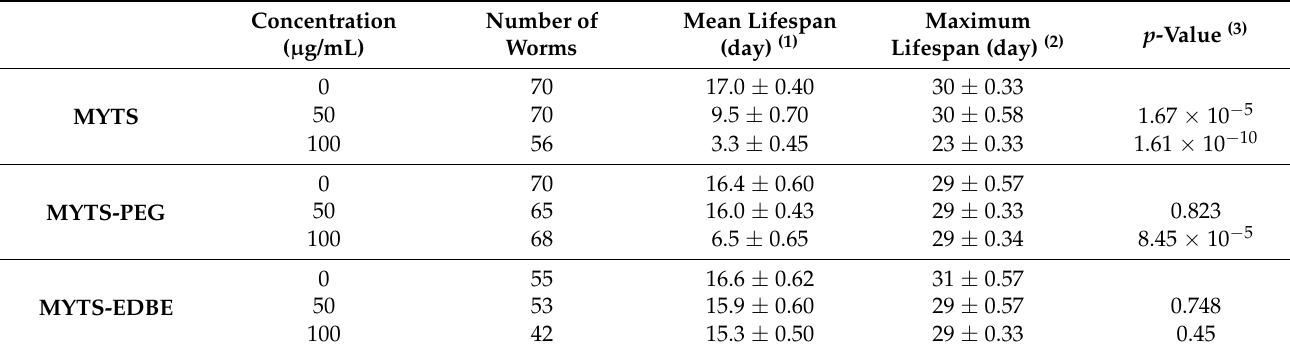
Table 2. Effect of the different NPs on longevity in C. elegans